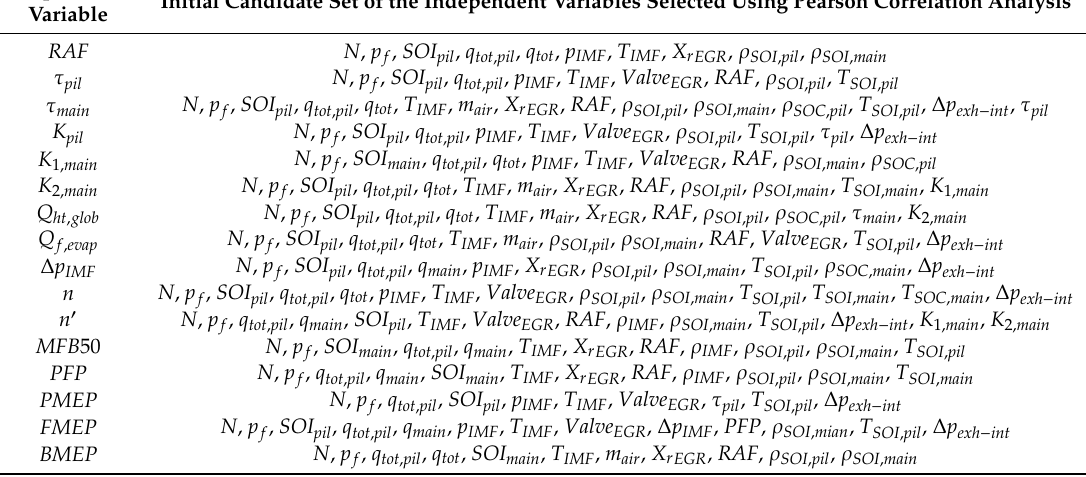
Table A2. Initial candidate set of the input variables for each output parameter, identified on the basis of the Pearson correlation